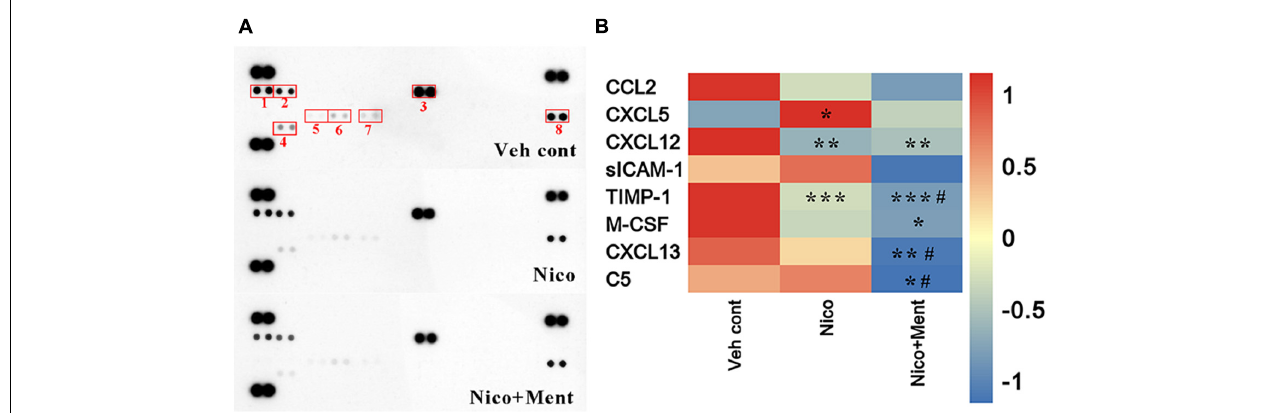
FIGURE 8 | The cytokine profile in the sera is altered by long-term vapor exposure. (A) Representative blots from serum samples of mice treated with long-term vapor exposures of vehicle control, ENDS, or ENDS with menthol flavor that presented levels of 40 known cytokines using the murine Proteome Profiler Cytokine Array. Spots showing differential expression are boxed. (1): CXCL13; (2): C5; (3): sICAM-1; (4): TIMP-1; (5): CXCL5; (6): M-CSF; (7): CCL2; (8): CXCL12. (B) Heatmap of quantification revealed significant changes greater than 1.2-fold, data were determined by ordinary one-way ANOVA and multiple comparisons with every other